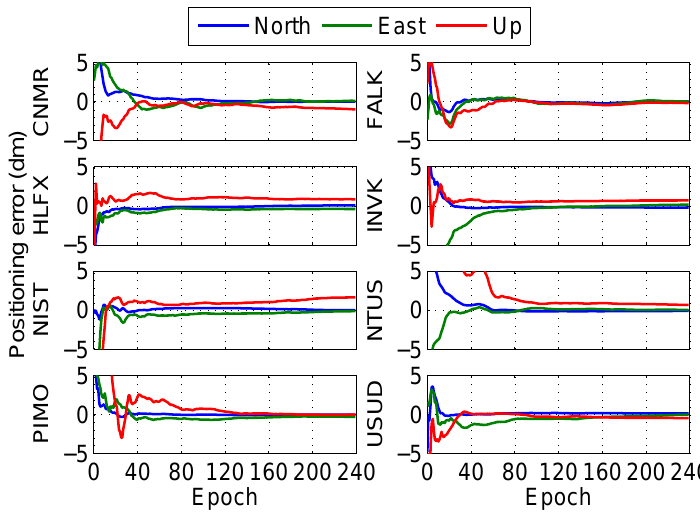
Figure 8. Positioning error of float solution at different stations in the post-processing